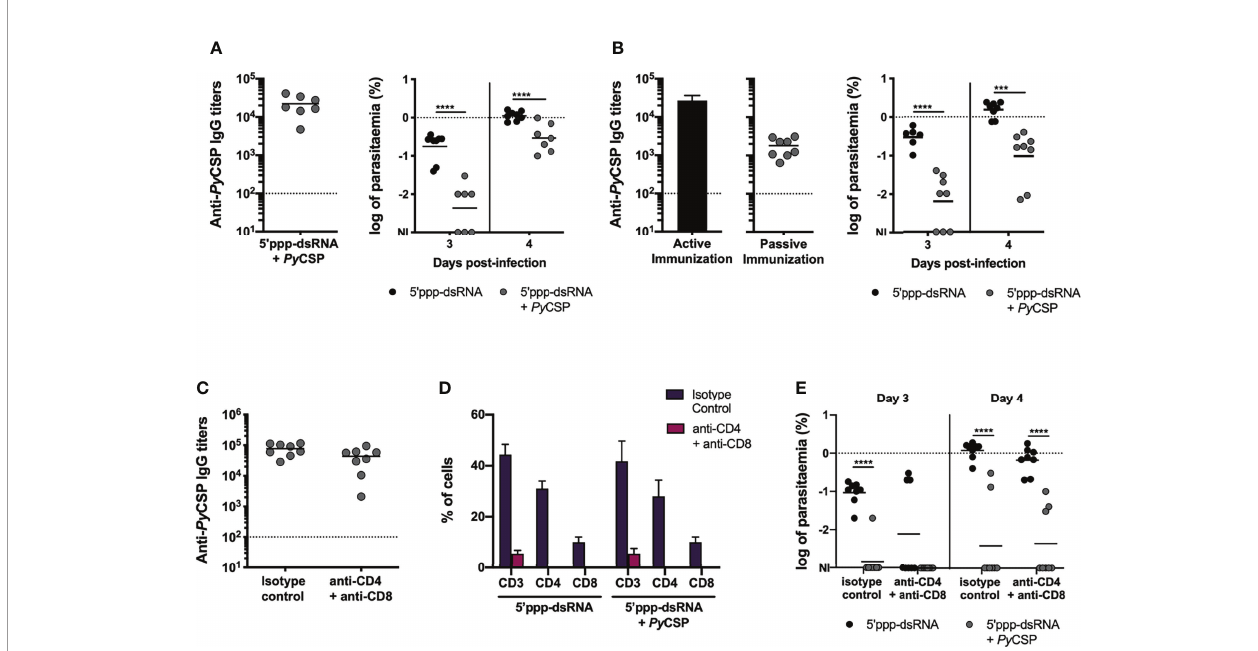
FIGURE 2 | Characterization of the mechanisms involved in short-term protection induced by immunization with Py CSP and 5 ’ ppp-dsRNA. (A) Protection to intravenous challenge in control mice (n = 8) and mice immunized with Py CSP in combination with 5 ’ ppp-dsRNA (n = 7, two independent experiments), 2 weeks post booster immunization. Left: Anti- Py CSP antibody titers in the sera of immunized mice. Symbols represent individual values and black lines the mean of each group. Dotted line represents the minimal detectable titers. Right: Log of parasitemia in immunized and control mice on days 3 and 4 post challenge with 2,500 sporozoites. Symbols represent individual values and black lines the mean of each group. The dotted line marks parasitemia of 1%. (B) Protection in mice which received the sera of control animals (n = 8), or sera of mice immunized with Py CSP plus 5 ’ ppp-dsRNA (n = 8, two independent experiments). Left: Anti- Py CSP antibody titers in the pool of sera transferred to naïve mice (bar, “ Active Immunization ” ) and in the sera of immunized mice 3 days after transfer (symbols, “ Passive Immunization ” ). The bar represents the mean ± SD obtained from two independent determinations. Symbols represent individual values and the black line the mean for the group. Dotted line represents the minimal detectable titers. Right: Log of parasitemia in control and immunized mice, at days 3 and 4 after skin challenge with 5,000 P.yoelii sporozoites. Symbols represent individual values and black lines the mean of each group. The dotted line marks parasitemia of 1%. (C – E) Protection to skin challenge in control and 5 ’ ppp-dsRNA-adjuvanted Py CSP-immunized mice which received isotype control antibody (n = 8, two independent experiments for both groups) or were depleted of CD4 and CD8 T cells (n = 8, two independent experiments for both groups), 2 weeks post booster immunization. (C) Anti- Py CSP IgG titers in the sera of immunized animals. Symbols represent individual values and black lines the mean of each group. Dotted line represents the minimal detectable titers. (D) Percentage of total CD3+, CD3+CD4+ and CD3+CD8+ T cells, within single cell lymphocyte population, in the peripheral blood of immunized and control animals. Bars represent the mean ± SD of the percentage for each group and cell population. (E) Log of parasitemia in control and immunized mice, on days 3 and 4 post infection. Symbols represent individual values and black lines the mean of each group. The dotted line marks parasitemia of 1%. Statistical signi fi cance was determined using 2-way ANOVA with Tukey ’ s multiple comparisons test (A, B, D and E) or two-tailed unpaired t test (C). NI, non-infected. ***p ≤ 0.001; ****p ≤